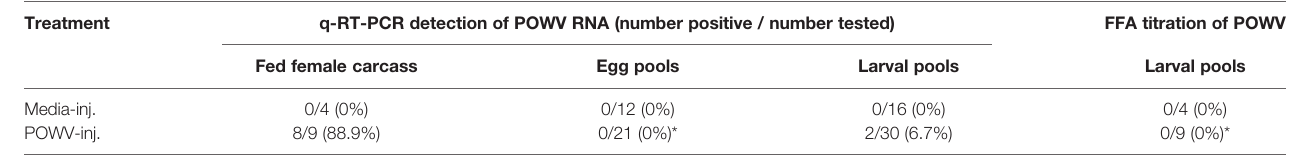
TABLE 3 | Detection of POWV RNA by q-RT-PCR and infectious POWV by FFA in H. longicornis fed adult carcasses, eggs, and larvae. Treatment q-RT-PCR detection of POWV RNA (number positive / number tested) FFA titration of POWV Fed female carcass Egg pools Larval pools Larval pools